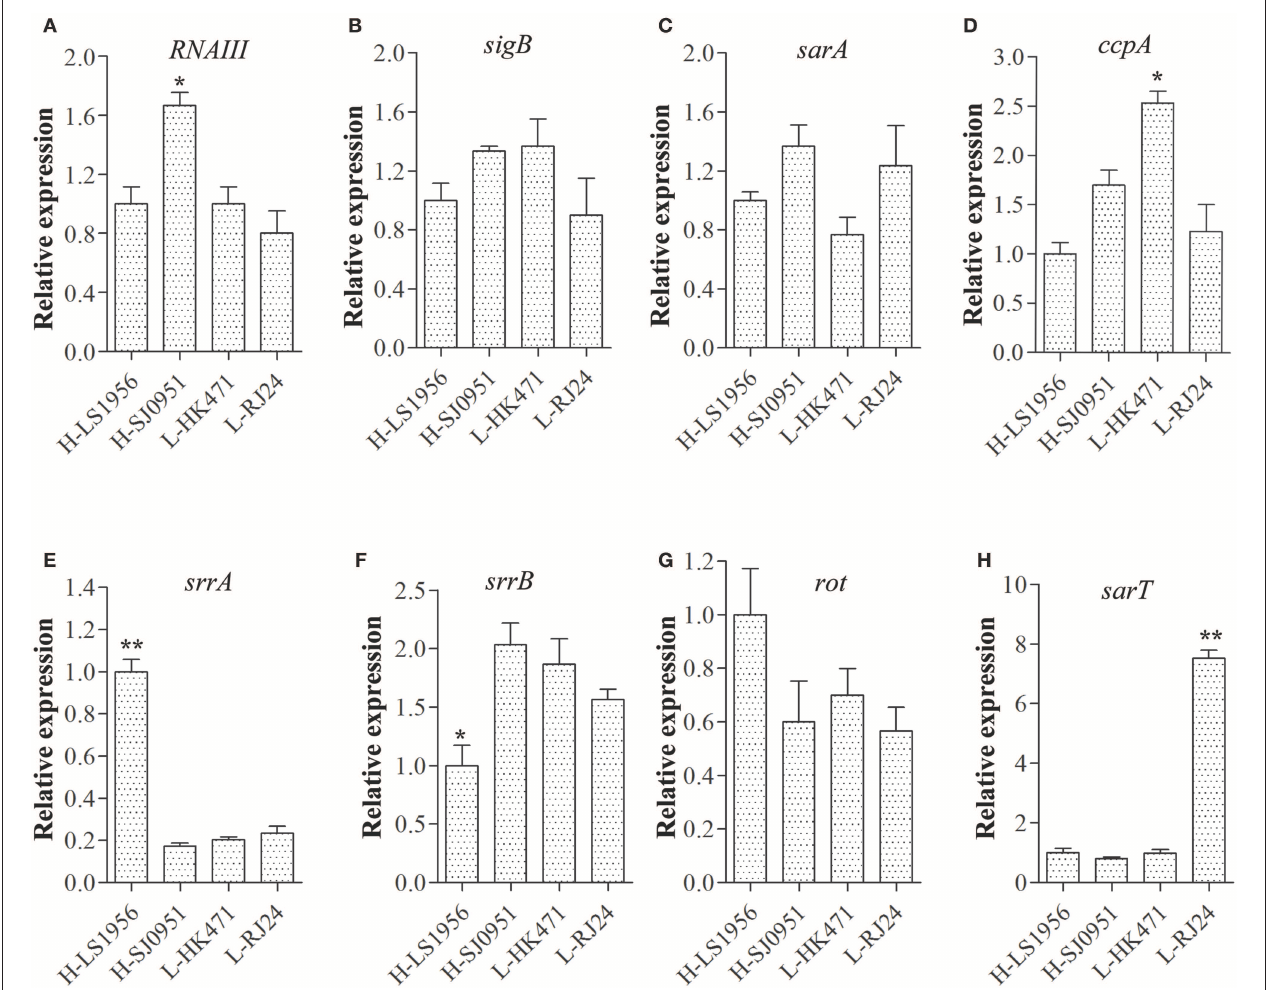
FIGURE 3 | Expression of major virulence regulator genes including RNAIII (A) , sigB (B) , sarA (C) , scpA (D) , srrA (E) , srrB (F) , rot (G), and sar T (H) in four tst differentially expressed S. aureus isolates. RNAIII in strain H-SJ0951, ccpA in strain L-HK471, srrA in strain H-LS1956, and sarT in strain L-RJ24 were detected to be highly expressed and srrB in strain H-LS1956 were detected to be lowly expressed in the post-exponential growth phase. Data are expressed as the means ± standard deviation (SD). Statistically significant differences were determined by ANOVA with LSD post-hoc test. * p < 0.05, ** p < 0.01 compared with the closest tst expression of one of the three strains. The experiment was independently repeated three